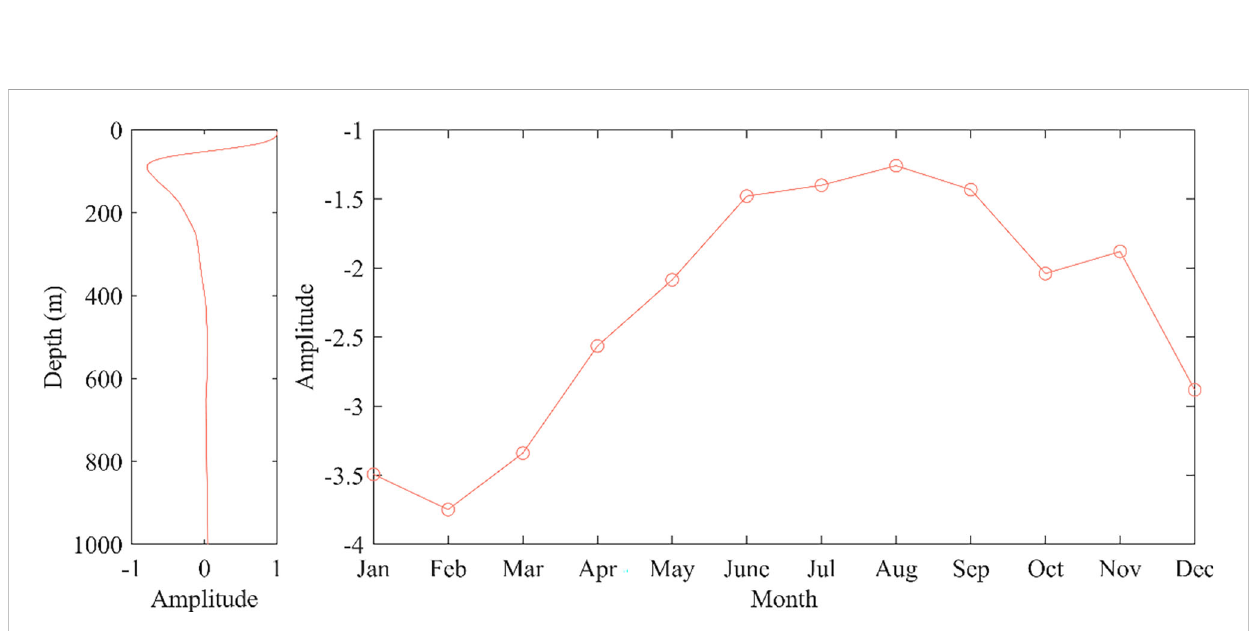
FIGURE 9 Time and space functions of Type